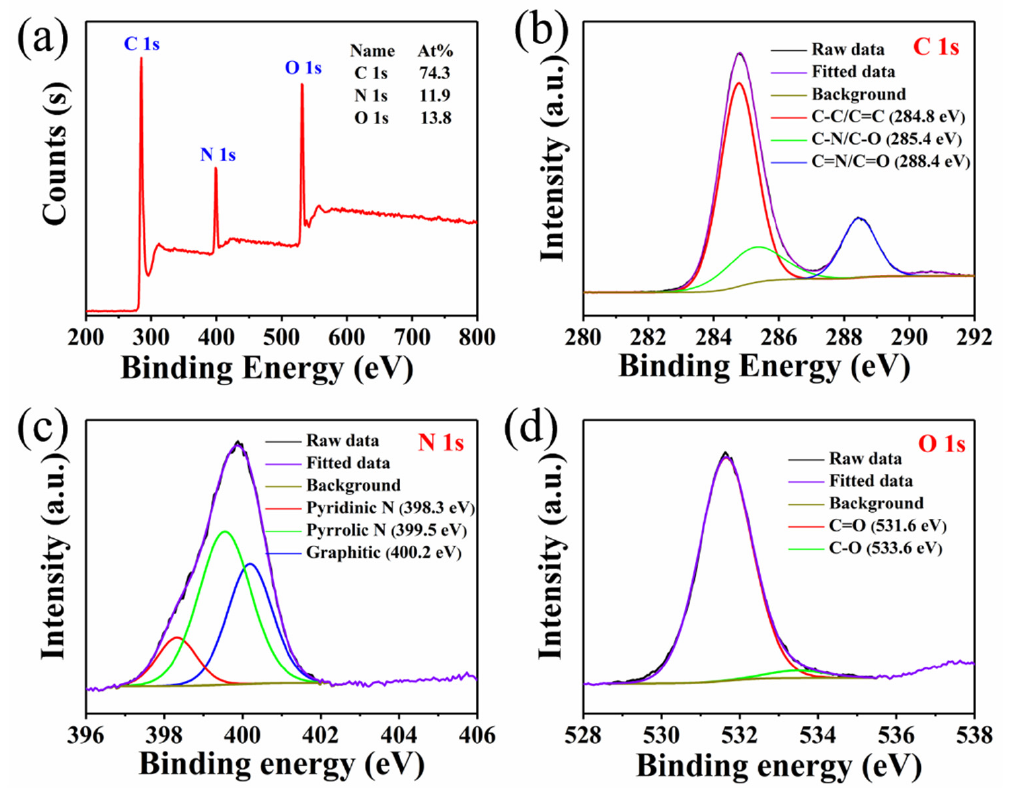
Figure 4. ( a ) X-ray photoelectron spectroscopy (XPS) survey spectra and high-resolution spectra of ( b ) C 1s ( c ), N 1s and ( d ) O ls of CQDs/PC phosphor.